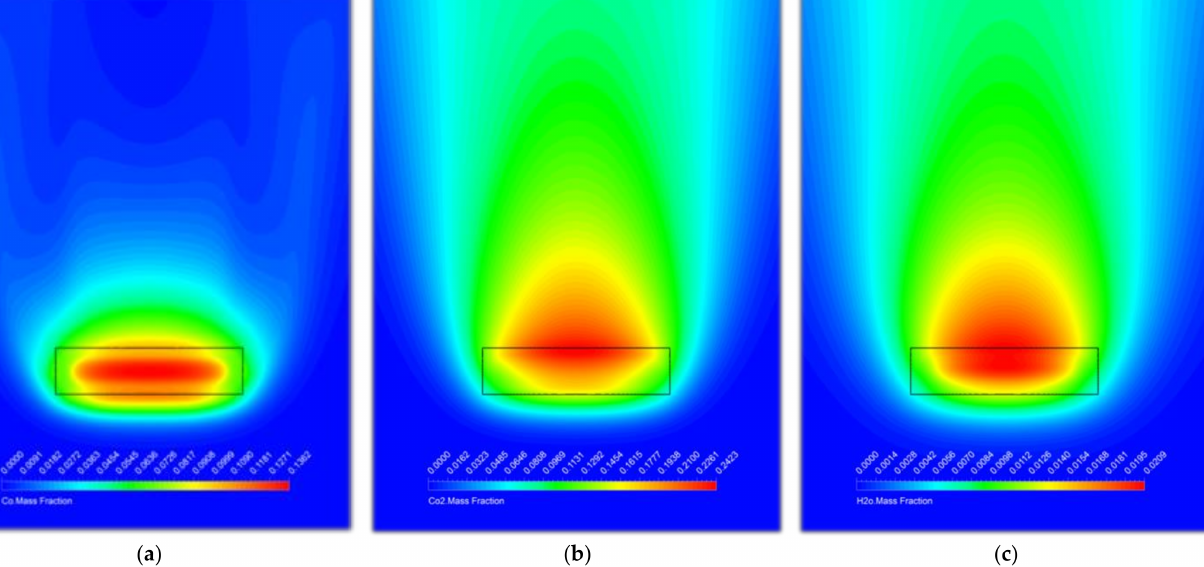
Figure 19. Mass fraction ( a ) CO, ( b ) CO 2 and ( c ) H 2 O at t = 50 s; maximum values ( a ) 0.1362, ( b ) 0.2423 and ( c ) 0.0209. Again, fuel gas mixture resulting from the biomass sample decomposition ignites late, only after approximately 18 s. The maximum flame temperature ( ≈ 2200 K) occurs this time during char combustion. During volatiles burning the maximum temperature reaches 1800 K. Burning intensity reduction is obvious for the second particle as well, with the minimum being at t = 65 s when the temperature reaches approximately 1550 K. Figure 20 shows that not only is the temperature evolution different during combustion, but also the flame shape, which was however predictable. Combustion is more intense towards particle ends, with the flame being shaped like a double cone. At t = 40 s, it should be noted